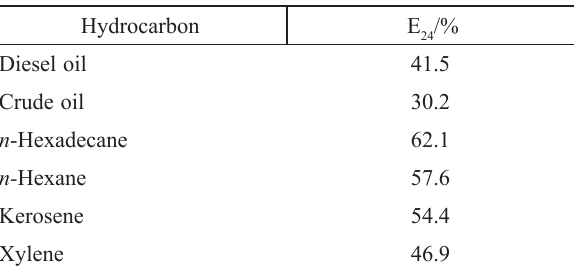
Table 3 – E value of the extracted biosurfactant against hy­ 24 drocarbons